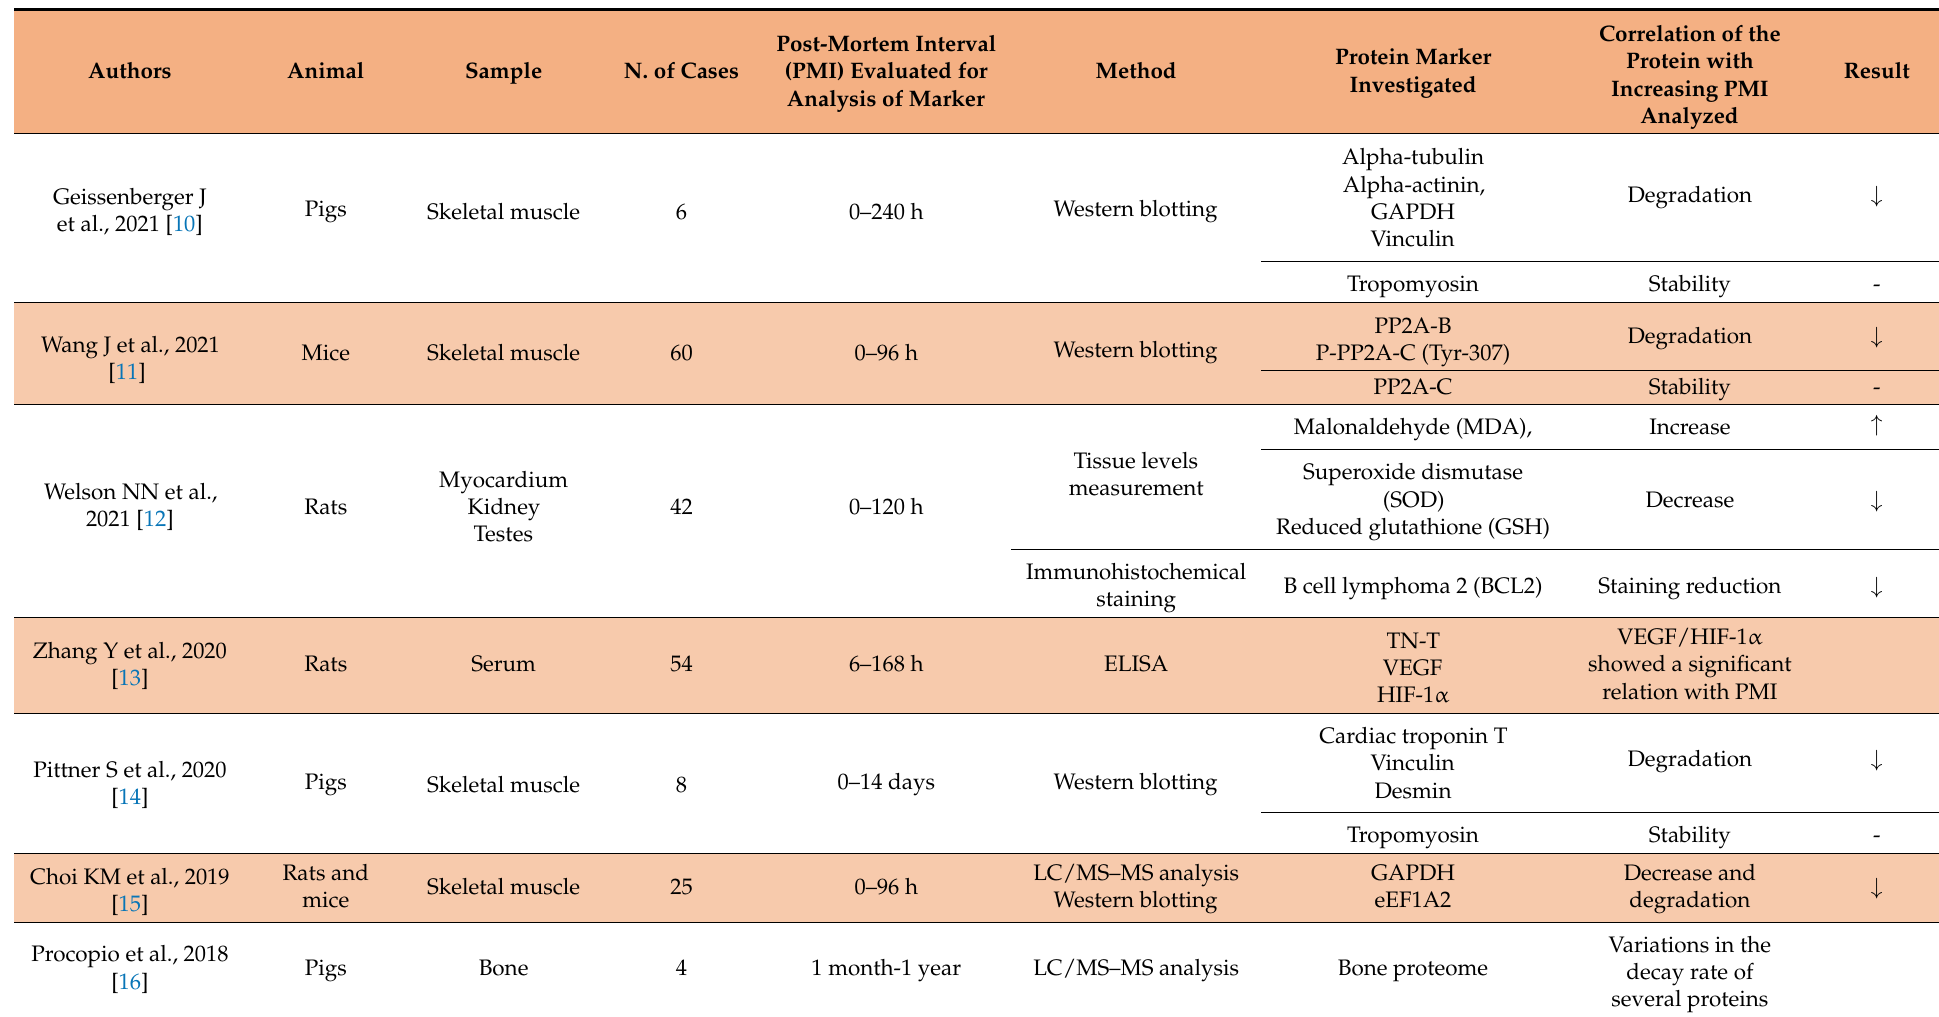
Table 1. Papers selected from the review on animal models, with analysis of the sample examined, number of cases, PMI investigated, method used, marker investigated and results. ↑ increase; ↓ decrease/degradation; - no